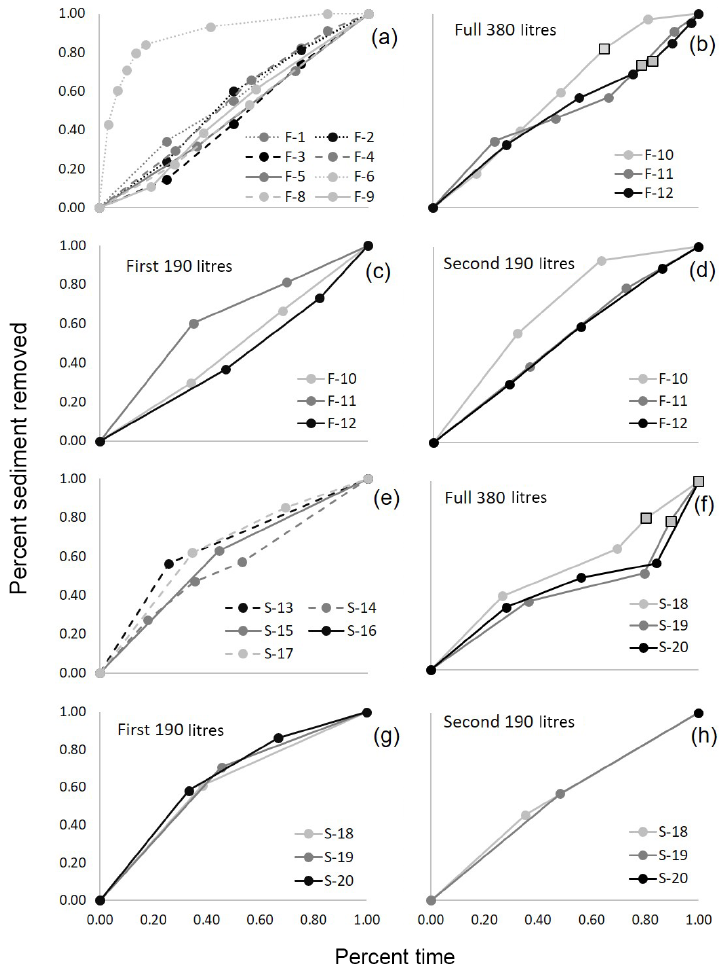
Figure 5. In general, sediment discharge was near constant throughout the experiments, as indicated by the linear relationship between percent time elapsed and percent of total sediment removed in the graphs above. This result was generally consistent between for both fine- grained substrate (a–d) and the sand substrate (e–h) . Results from the 190L runs are graphed in (a) and (e) and the 380L runs are graphed in (b) and (f) with the first half broken out in (c) and (g) and the second half in (f) and (h)